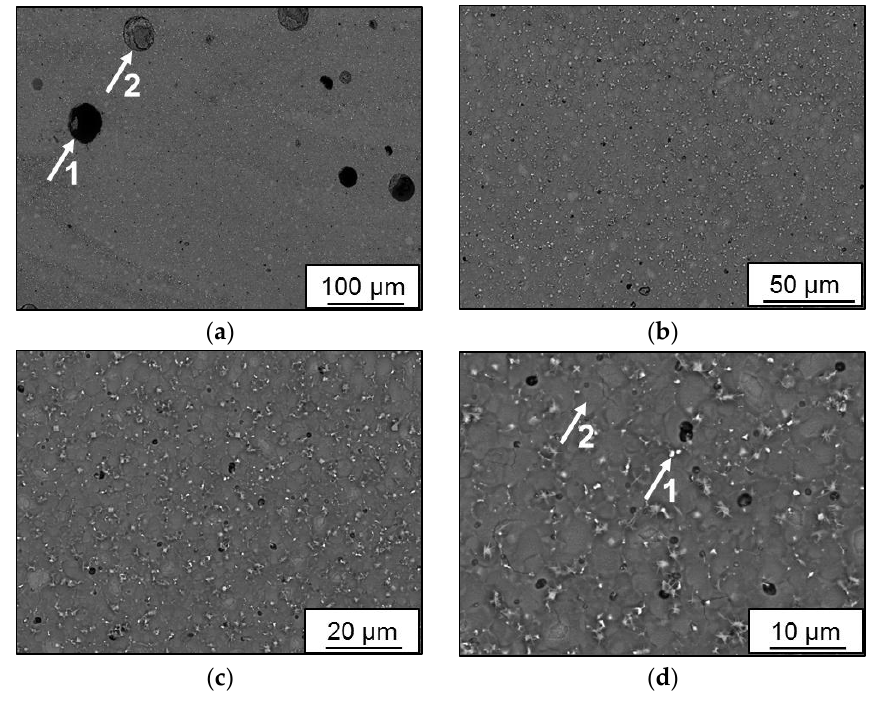
Figure 7. Scanning electron microscopy (SEM) micrographs in melt tracks of batch C (Scalmalloy ® LMD): ( a ) 200X; ( b ) 500X; ( c ) 1000X; ( d ) 2000X.